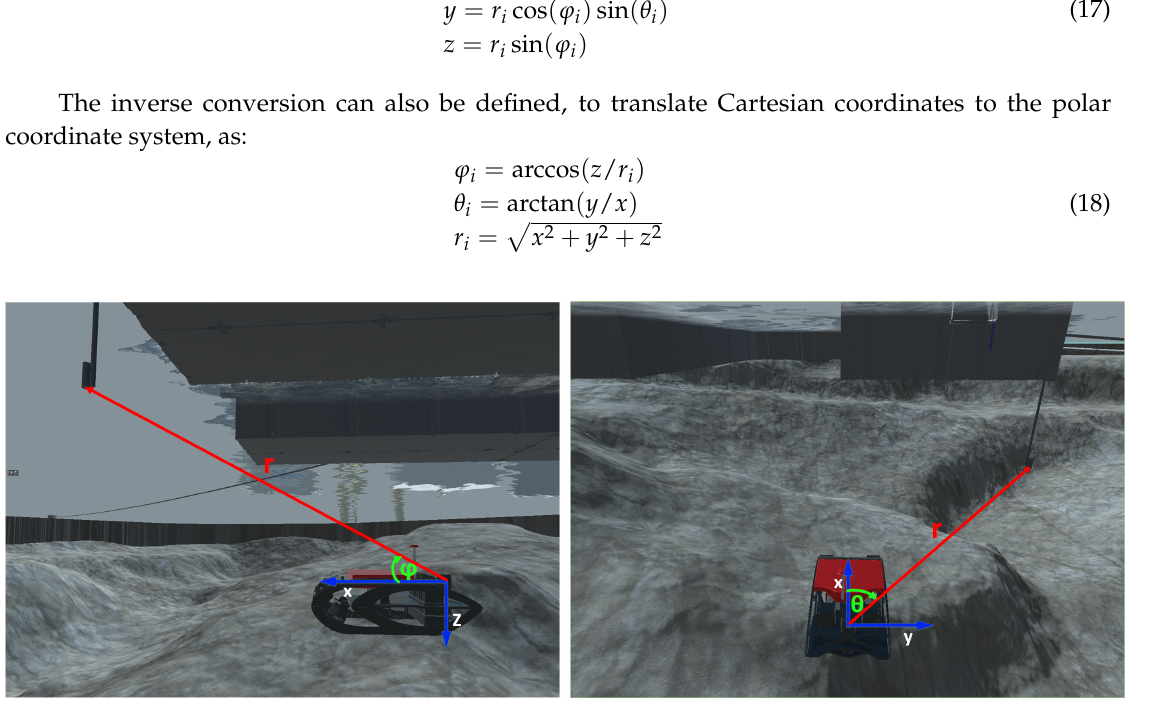
Figure 7. Illustration of the polar observation obtained through the iUSBL: ( a ) elevation angle and range; ( b ) bearing angle and